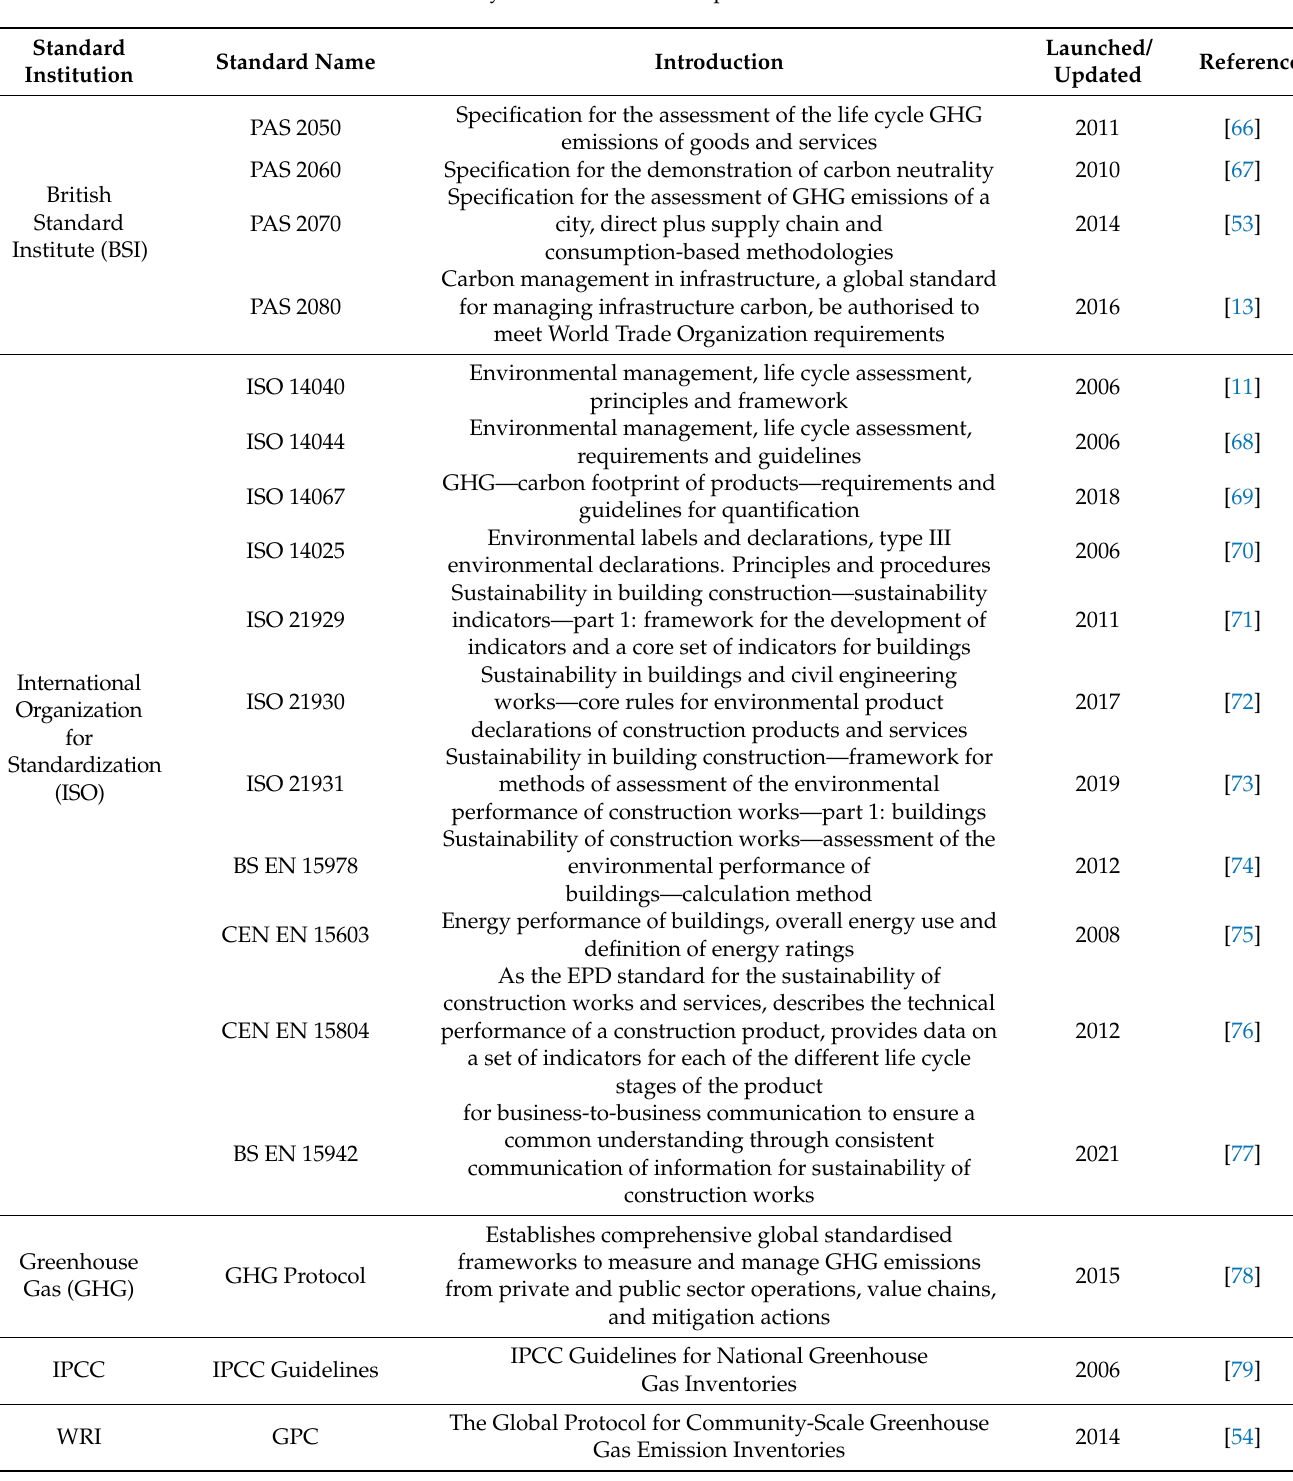
Table 4. Summary of CF standards and